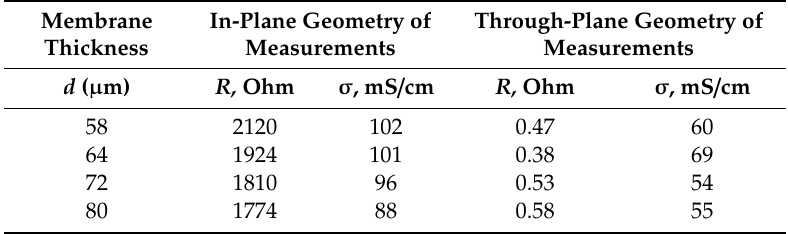
Table 1. In-plane and through-plane resistance R and conductivity σ versus the membrane thickness ( d ).